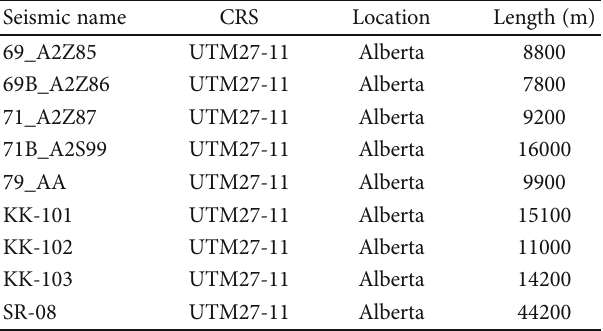
Table 2: Basic seismic pro fi le information used in this study. The CRS (Coordinate Reference System) was set by UTM27-11 to use, and well to seismic calibrated pro fi les were KK-101 and